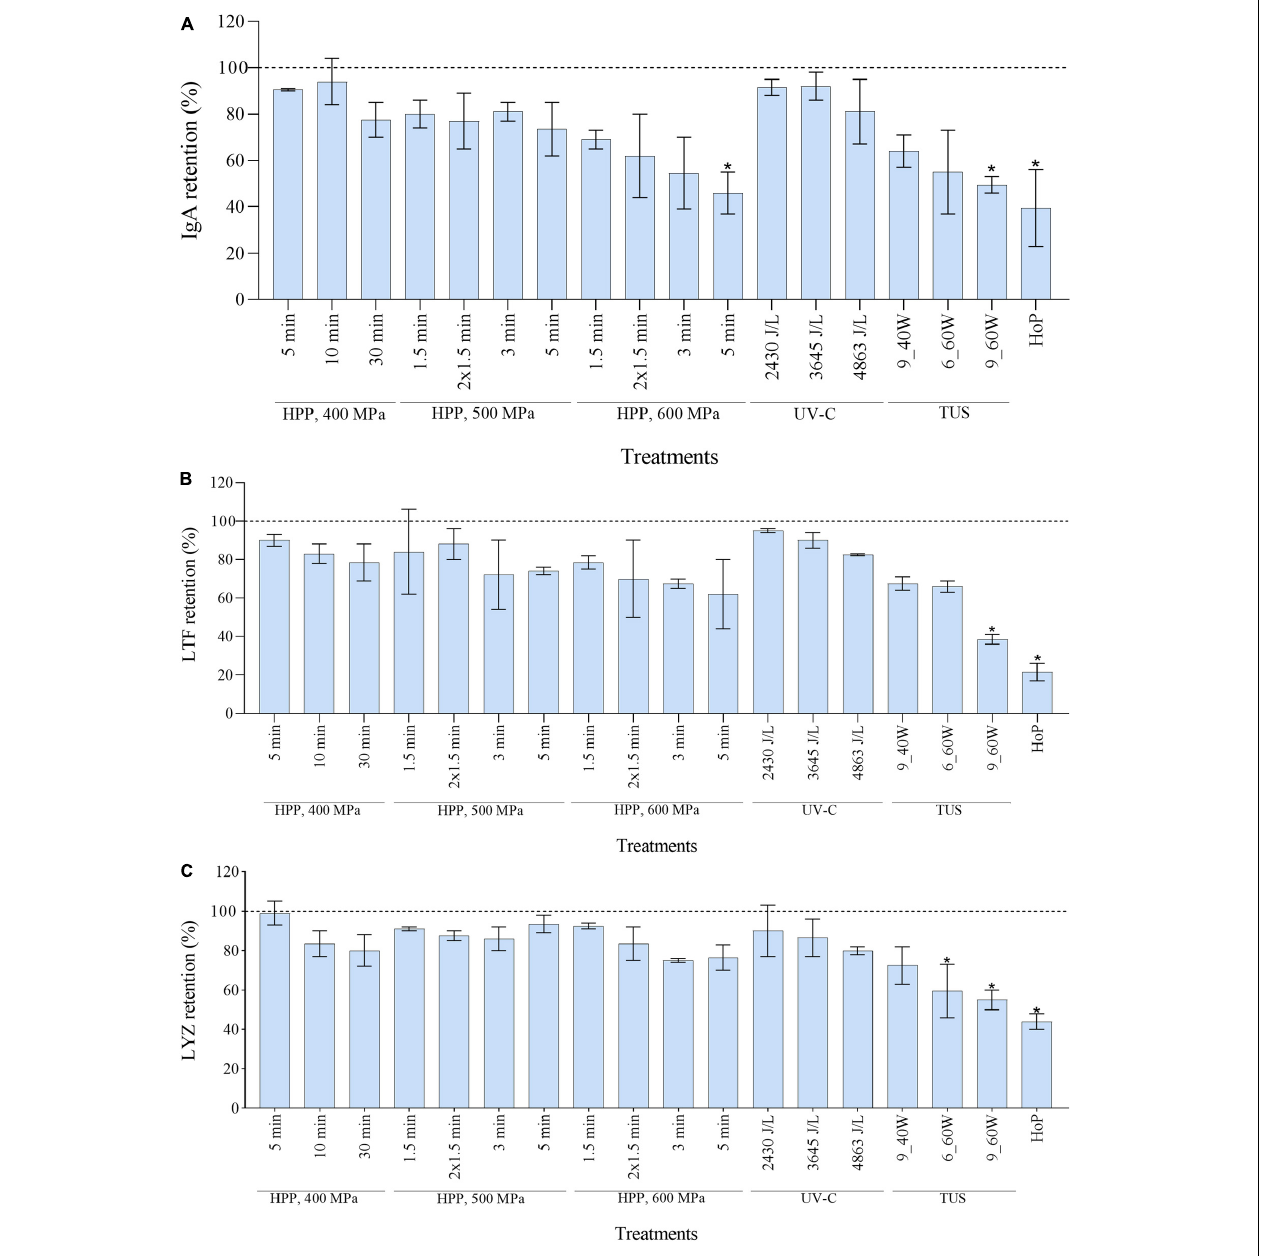
FIGURE 4 | Effect of HPP, UV-C, TUS and HoP on the IgA (A) , LTF (B) , and LYZ (C) content. The retention values were calculated based on the iBAQ intensities obtained by LC-MS/MS analysis. Untreated values were set at 100% (dotted line). The results are presented as mean ± standard deviation of two independent experiments and all analyses were performed in technical duplicate.*Indicates significant differences to untreated samples ( p <